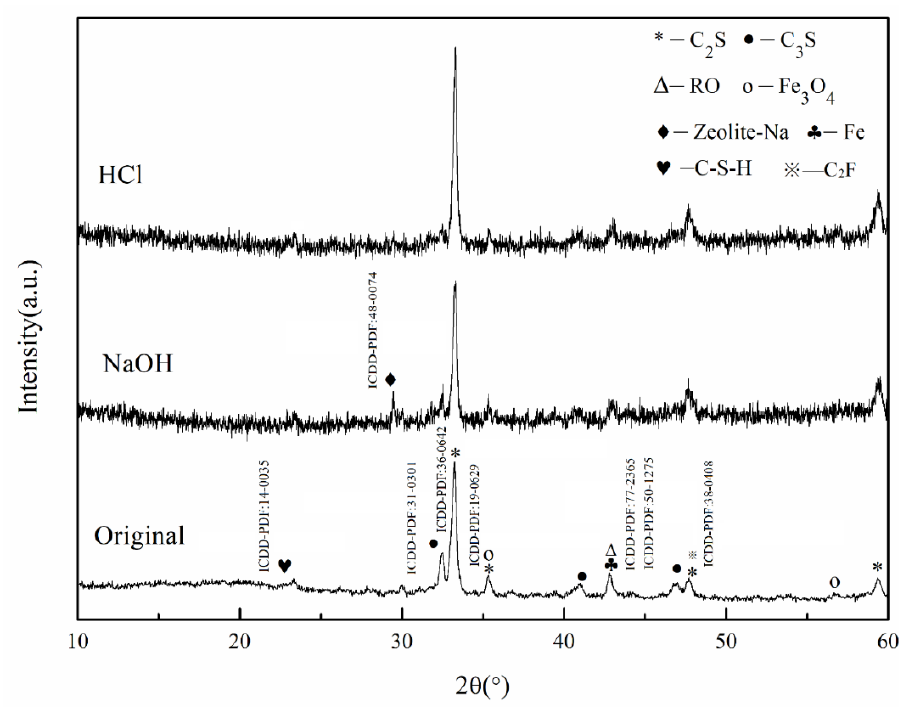
Figure 7. XRD of the samples before and after acid – alkali